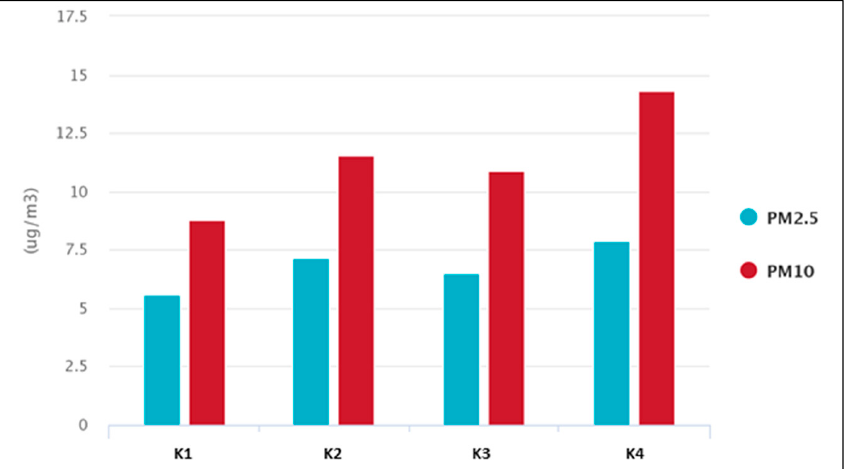
Figure 7. Average concentrations of PM for 4 measurement locations over the experimental period 20 August–15 September 2022.